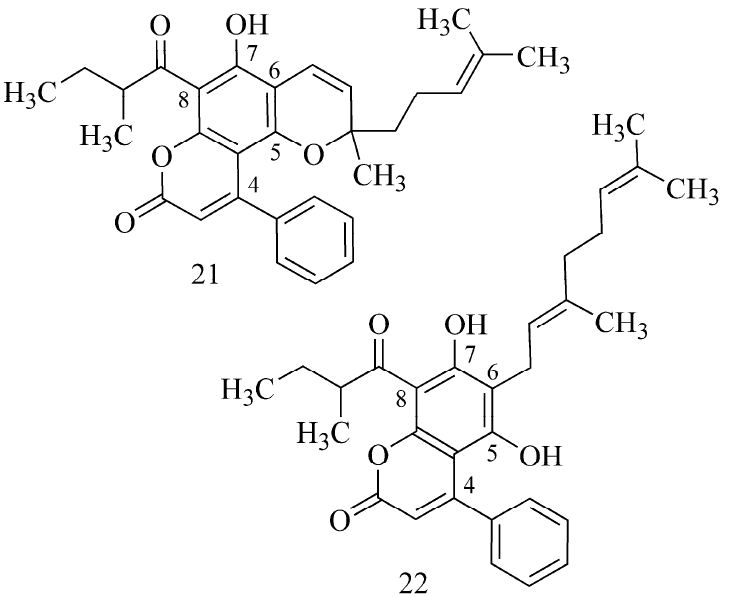
Figure 8. Chemical structures of mesuagenin B ( 21 ) and 5,7-dihydroxy-8-(3-methylbutanoyl)-6-[( E )-3,7-dimethylocta-2,6-dienyl]-4-phenyl-2H-chromen-2-one ( 22 ). (*Stereochemistry not determined).